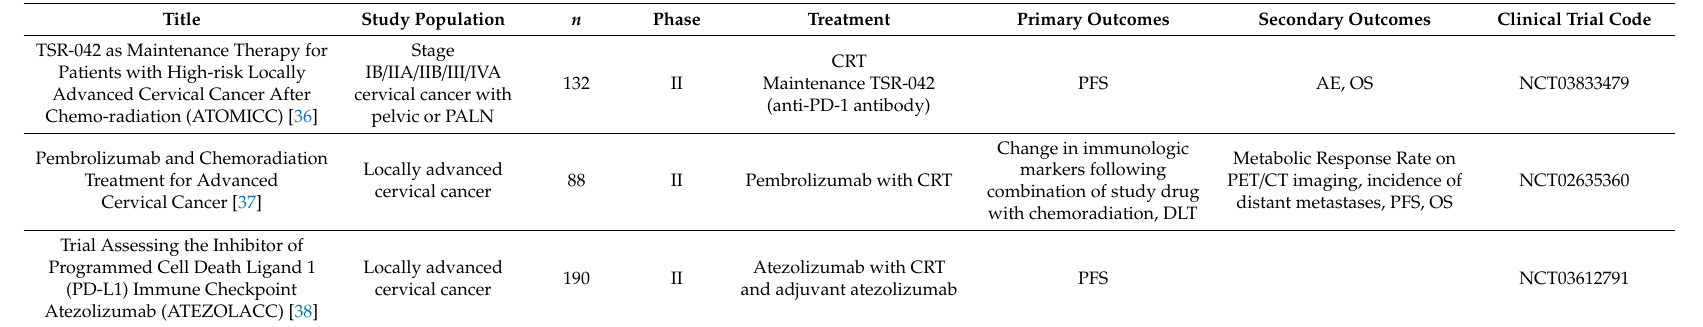
Table 4. Ongoing clinical phase II trials, CCRT with ICIs for cervical